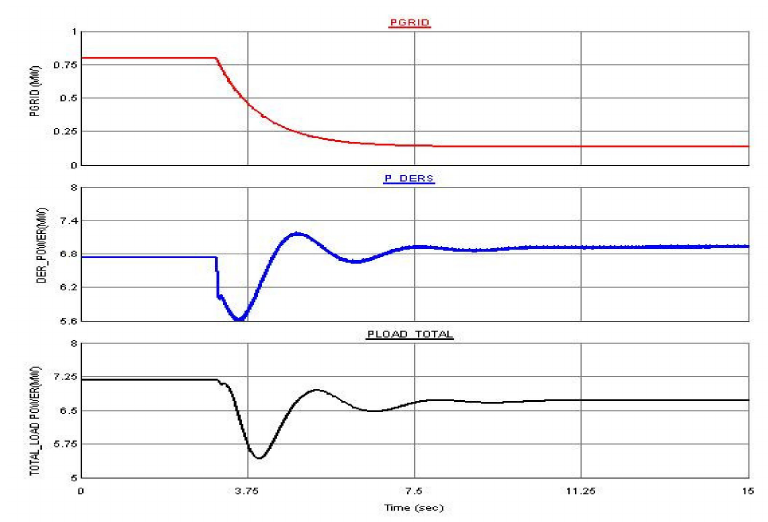
Figure 9. Microgrid system frequency before and after islanding.